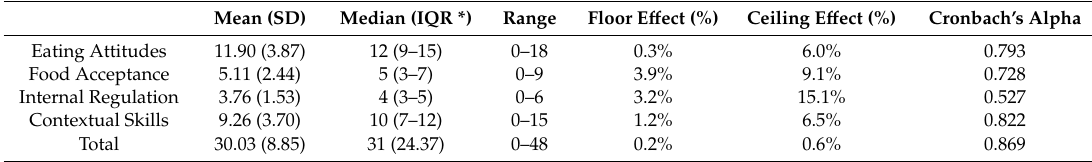
Table 3. The ecSI2.0 TM BR scores, responsiveness, and internal consistency of the questionnaire.